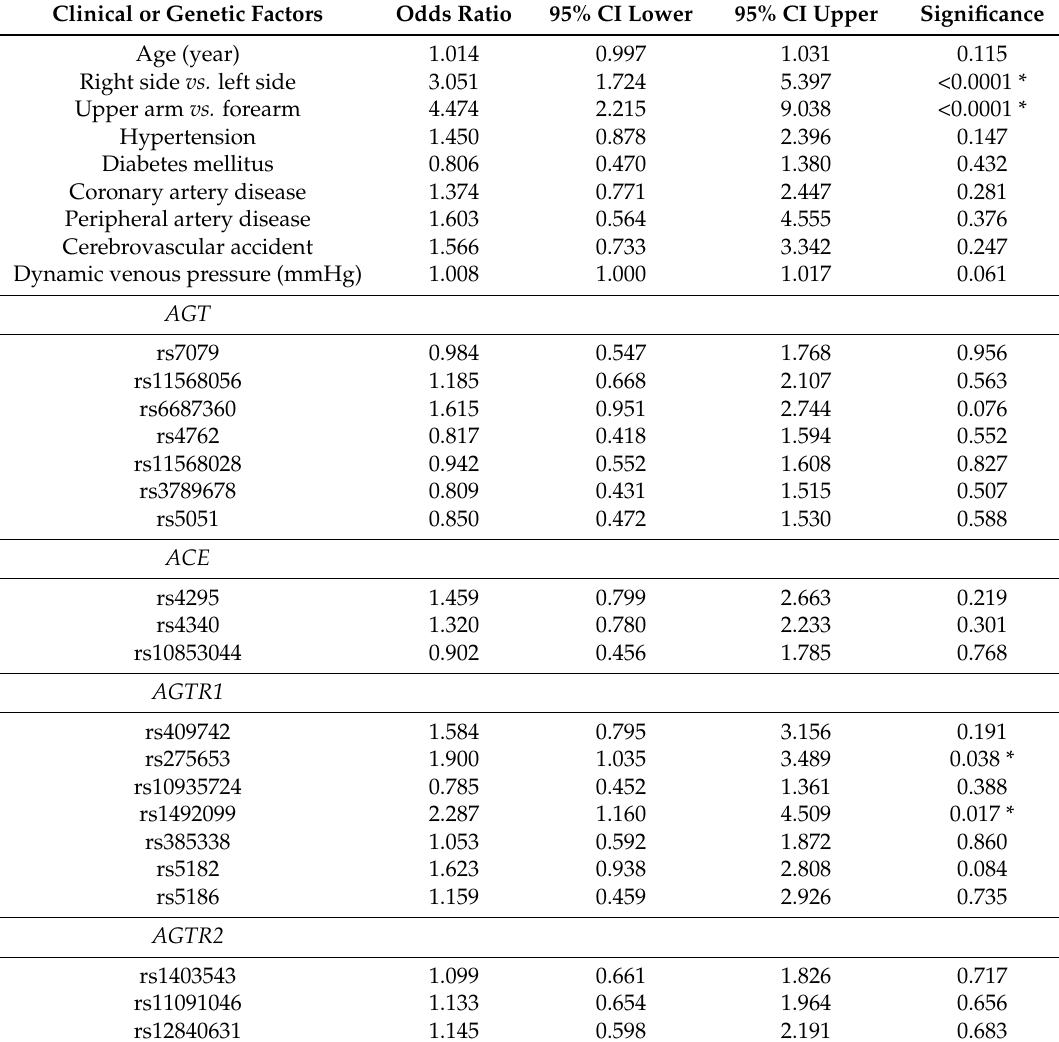
Table 5. Univariate logistic regression model of factors associated with AVF malfunction in male HD